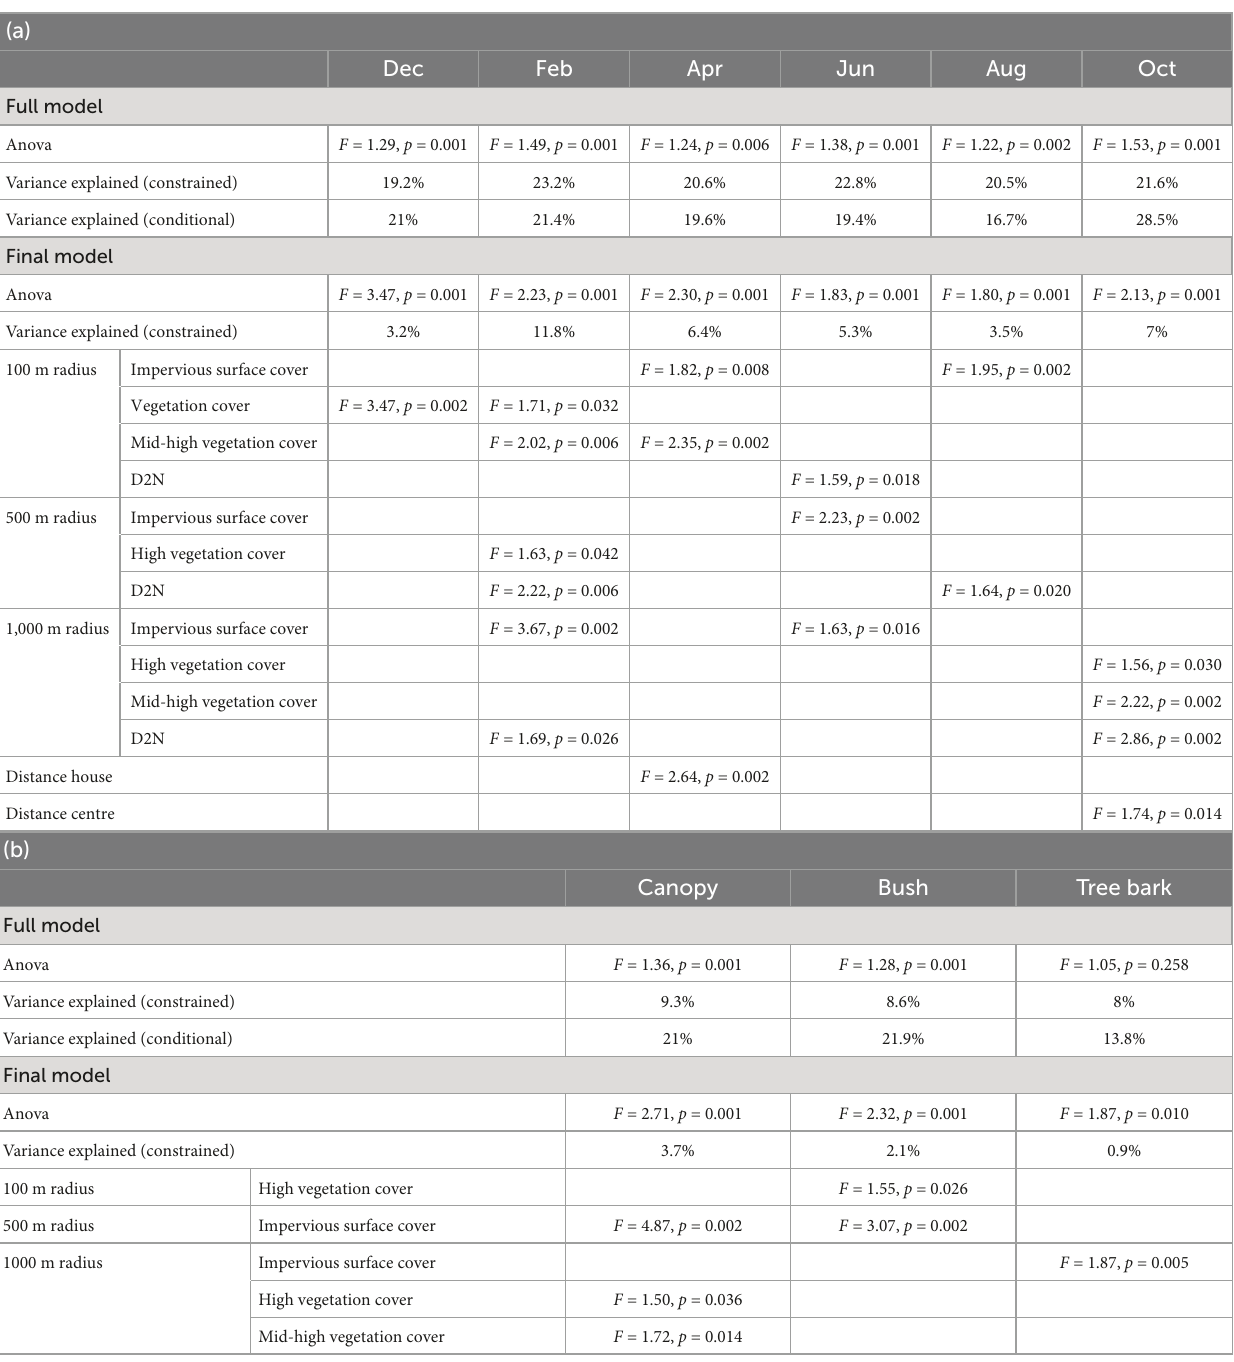
TABLE 3 Results of the ordination analyses per (a) month and (b) per